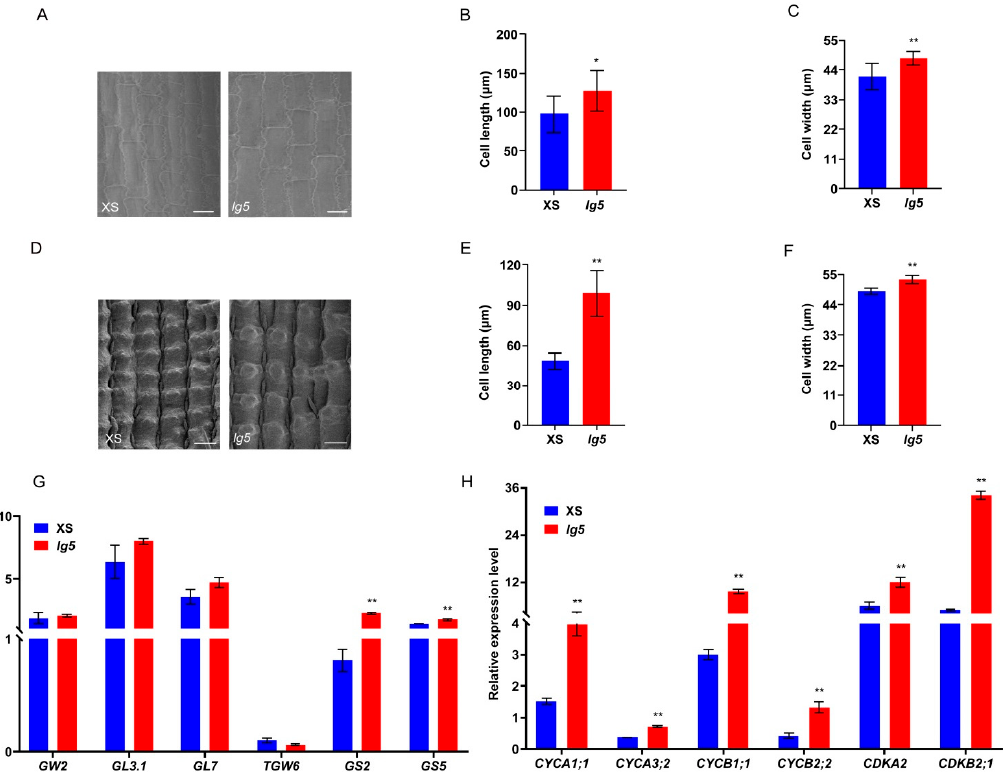
Figure 6. Scanning electron microscope and RT-PCR analysis of XS and lg5 . ( A – C ) Cell length and width of the inner grain hulls; bar = 50 μ m. ( D – F ) Cell length and width of the outer grain hulls; bar = 50 μ m. ( G , H ) Expression of cell expansion and cell proliferation genes and expression of cell cycle genes in young panicles, with the rice UBIQUITIN gene as an internal control. Data are presented as means ± SD. * and ** indicate p < 0.05 and p < 0.01, respectively, according to Student’s t -test.